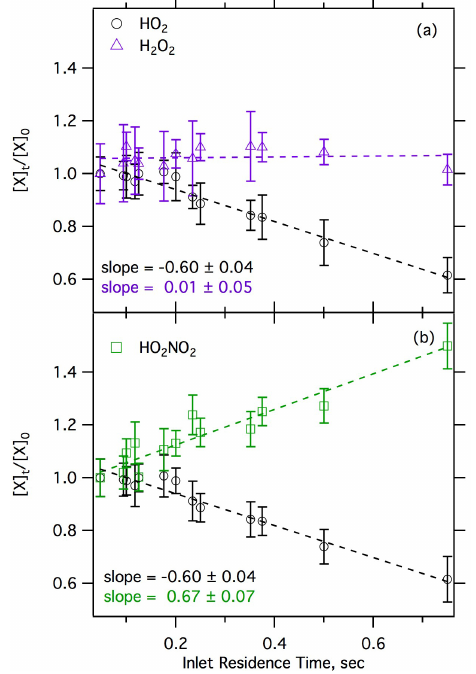
Figure 2. Observed losses versus inlet residence times for a gener- ated standard of HO 2 radicals sampled through PFA tubing at var- ious flow rates (3–6 standardLmin − 1 ) and lengths (0–3m). Con- centrations have been normalized to the initial concentration ob- served at the minimum reaction time displayed. Reaction with NO 2 to form HO 2 NO 2 appears to be the dominant loss for HO 2 on these